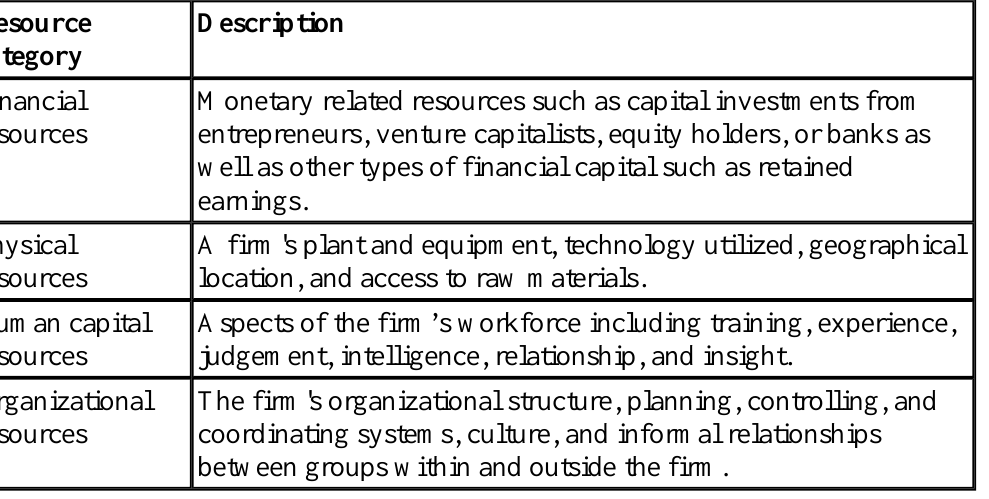
Table 3 Firm resource categories (Powers